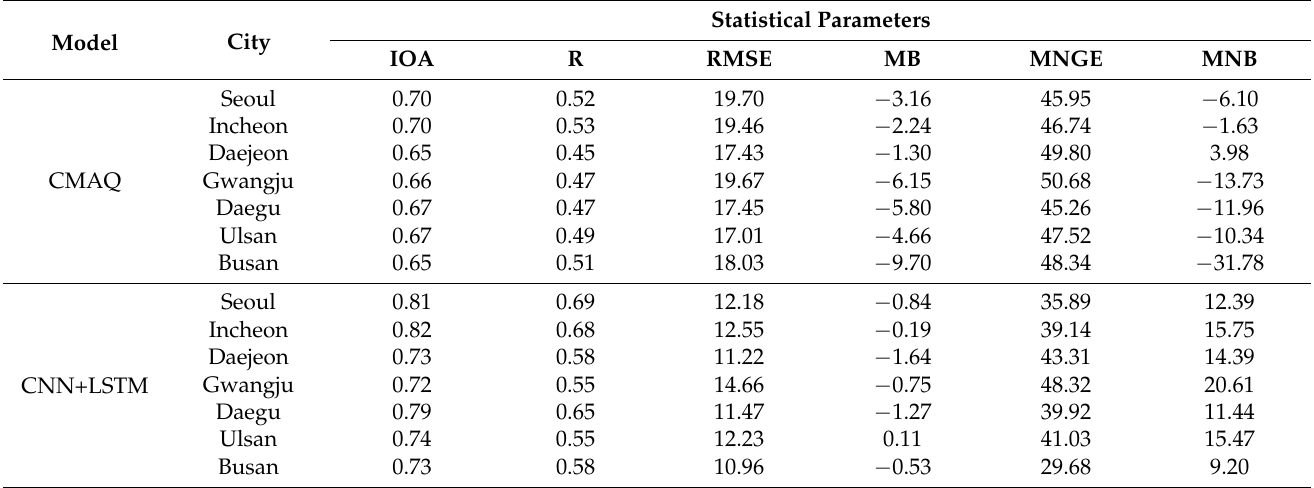
Table 5. Scientific evaluations of the CMAQ- and CNN+LSTM-based PM 2.5 predictions *.